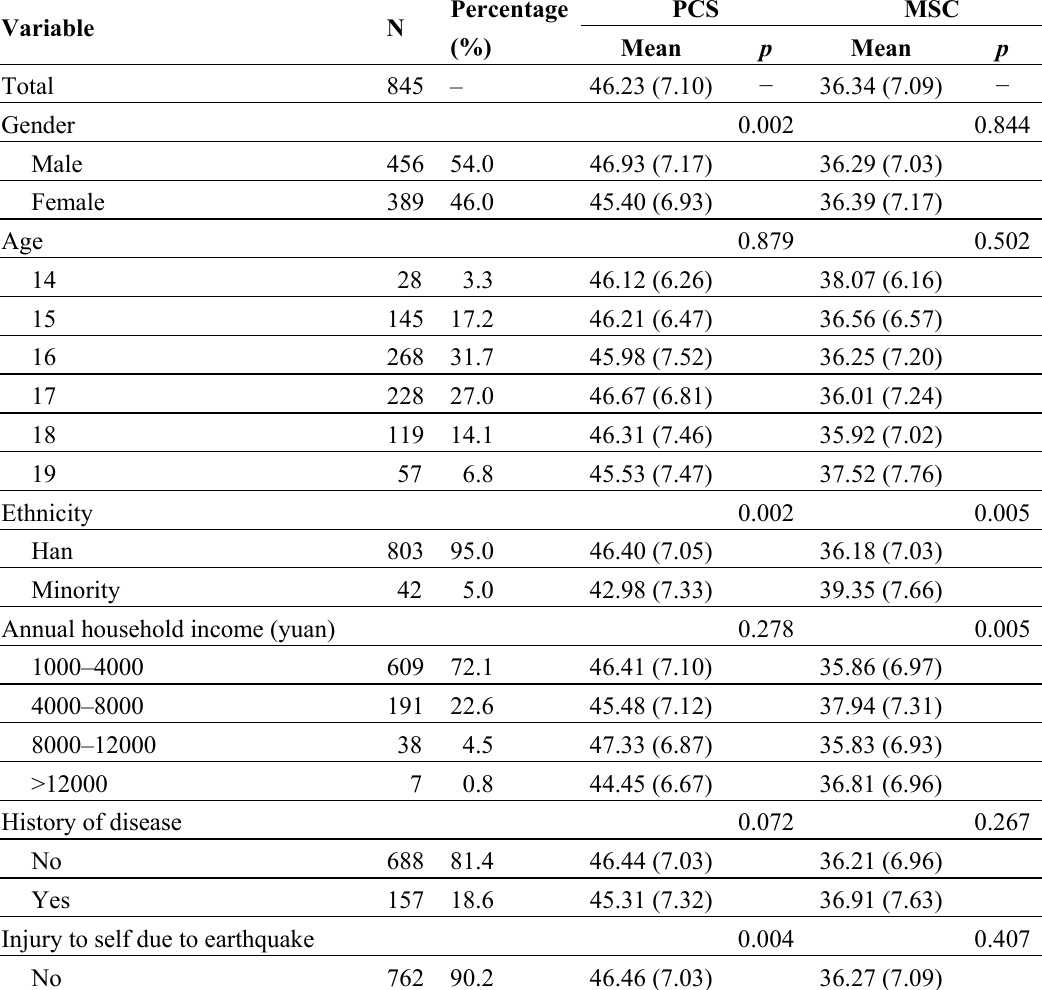
Table 1. Demographics and earthquake-related experiences among adolescent survivors of the Ludian earthquake,